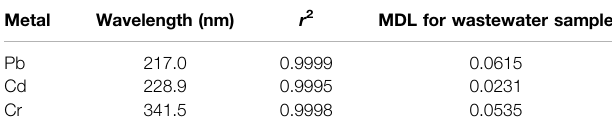
TABLE 1 | Method detection limits for wastewater samples. Metal Wavelength